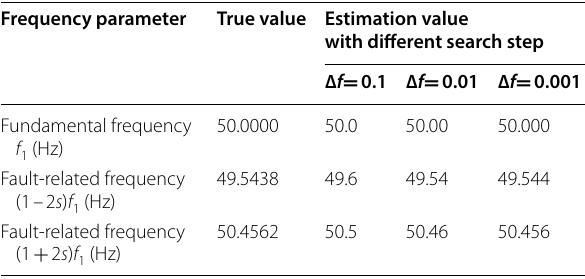
Table 2 MUSIC estimation results with different